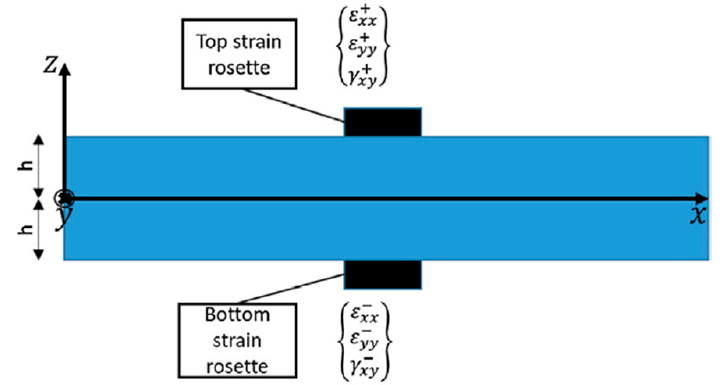
Figure 2 . Discrete sensor location on the shell structure. Figure 2. Discrete sensor location on the shell